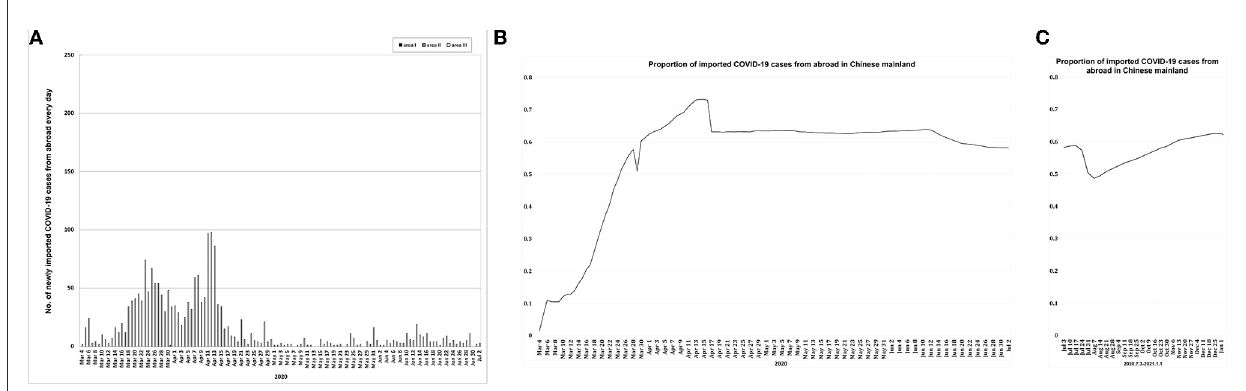
FIGURE6 Data of imported COVID-19 cases from abroad. (A) Daily increase of imported COVID-19 cases from abroad in areas I, II and III from March 4, 2020 to July 2, 2020. (B, C) Proportion of cumulative imported COVID-19 cases from abroad to cumulative COVID-19 cases in Chinese mainland (area V) from March 4, 2020 to January 1, 2021. Area I, Wuhan city. Area II, Hubei province (excluding Wuhan city). Area III, Chinese mainland (excluding Hubei province). The data of imported COVID-19 cases from abroad could be obtained through the websites of health committees at all levels only after March 2 or 3,